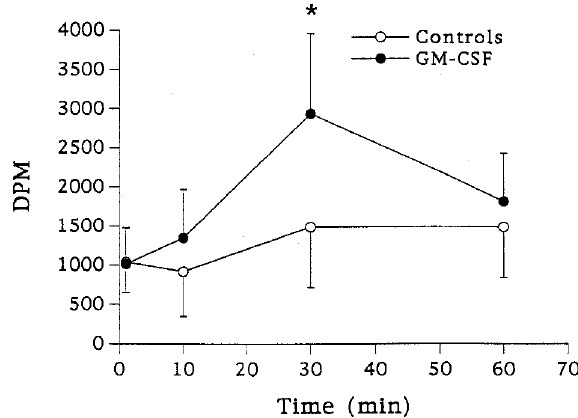
FIG.2. Trafficking of [ 3 H]-AA into PL species of bone marrow mononuclear cells. Cells were labelled for 0.5h with [ 3 H]-AA. Medium was removed and cells were incubated with medium free of [ 3 H]-AA for 2, 5 or 22h. Results are expressed as the percentage of total radioactivity found in PL species. Mean ± SEM of three independent experiments in duplicate. PC: phosphatidylcholine; PE: phosphatidyle- thanolamine; PI + PS: phosphatidylinositol + phosphati- dylserine (comigration).